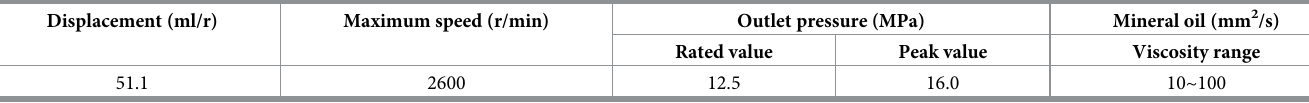
Table 3. Main performance parameters of gear